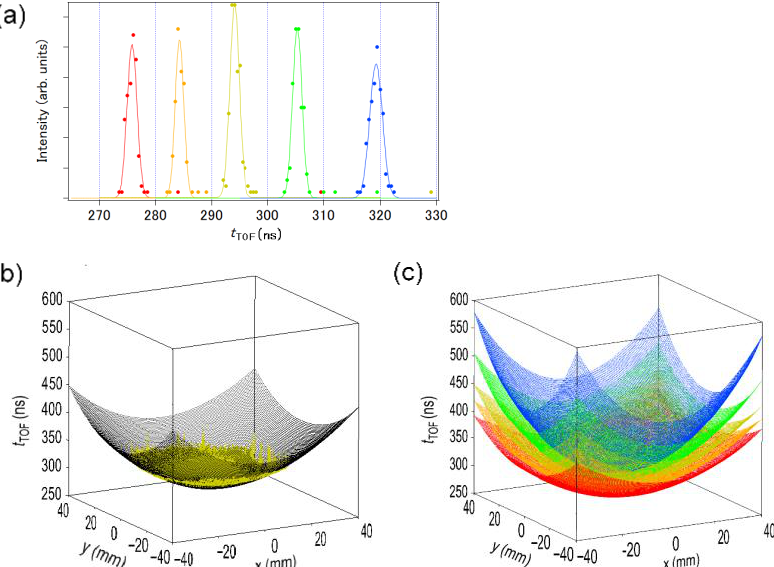
Figure 5. ( a ) The distributions of t TOF for electrons scattered by Ne atoms and detected at ( x , y ) = (5 mm, − 5 mm) on the time-and-position sensitive detector at the incident electron kinetic energies of E i /eV = 1000 + 1.55 n with n = +2 (red), n = +1 (orange), n = 0 (yellow), n = − 1 (green), and n = − 2 (blue). The solid curves represent best-fit Gaussian curves to the recorded data represented by the dots. ( b ) The position dependence of the mean value of t TOF at E i = 1000 eV. Each one of the yellow dots represents the mean value of t TOF obtained as the center of the best-fit Gaussian curve. The meshed surface (black) is a smoothed surface constructed using the yellow dots. ( c ) Smoothed surfaces for the position dependence of the mean values of t TOF at the five different incident electron kinetic energies for n = +2 (red), n = +1 (orange), n = 0 (yellow), n = − 1 (green), and n = − 2 (blue). The yellow solid line in Figure 5a for the acceleration voltage of 1000 eV with ∆ E calib = 0 is a best-fit curve for the experimental data obtained by a least-squares analysis using a Gaussian model function. After determining t TOF as the center of the best-fit Gaus- sian function, the distribution of t TOF was plotted as a yellow dot in the 3D space at ( x , y , t TOF ) = (5 mm, − 5 mm, t TOF ). The same analyses were made for all the grid points and plotted to form the convex-downward surface shown in Figure 5b. The black meshed surface in Figure 5b is a smoothed convex-downward surface composed of the yellow dots representing all the grid points. The convex-downward shape reflects the fact that, at a given electron kinetic energy, the electrons scattered elastically in the larger polar angle ( θ ) range take the longer flight time to reach the detector because of the longer trajectories. For the other four kinetic energies of the incident electrons of 996.90 eV, 998.45 eV, 1001.55